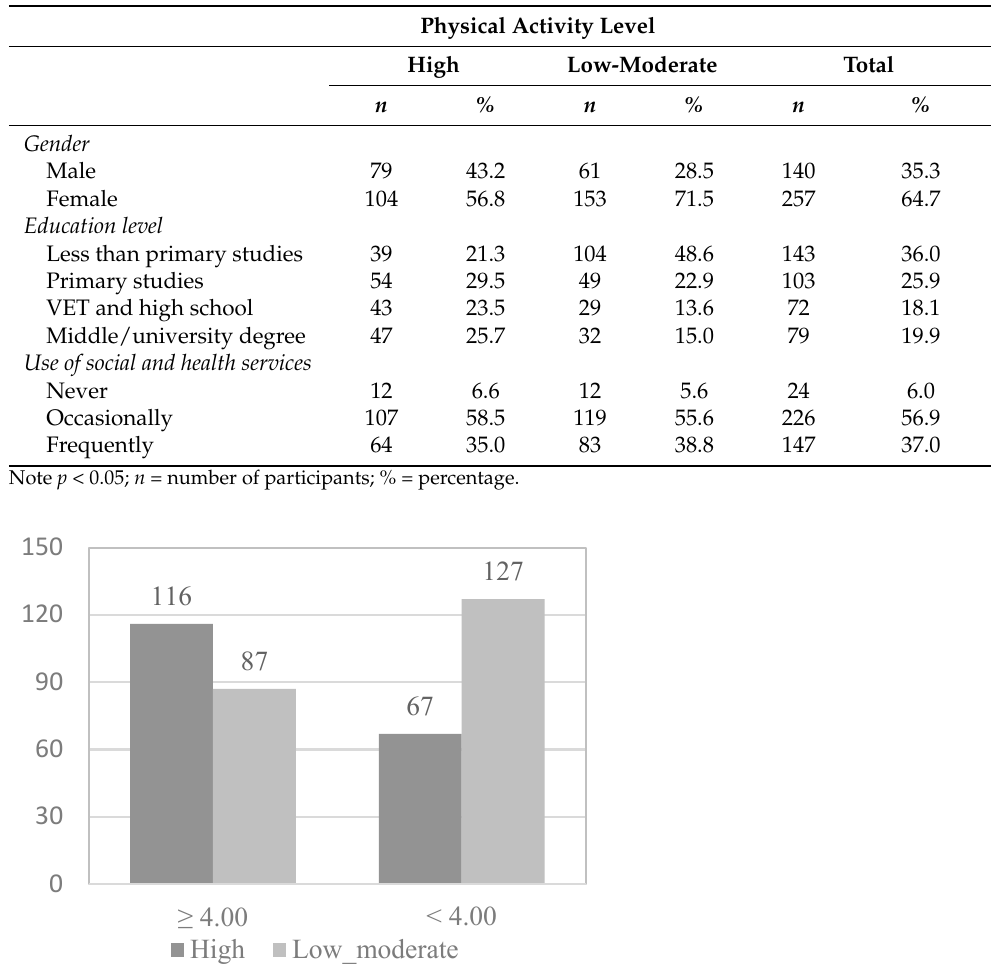
Table 2. Frequencies of gender, level of studies, and use of socio-health services according to the level of physical activity of the participants.